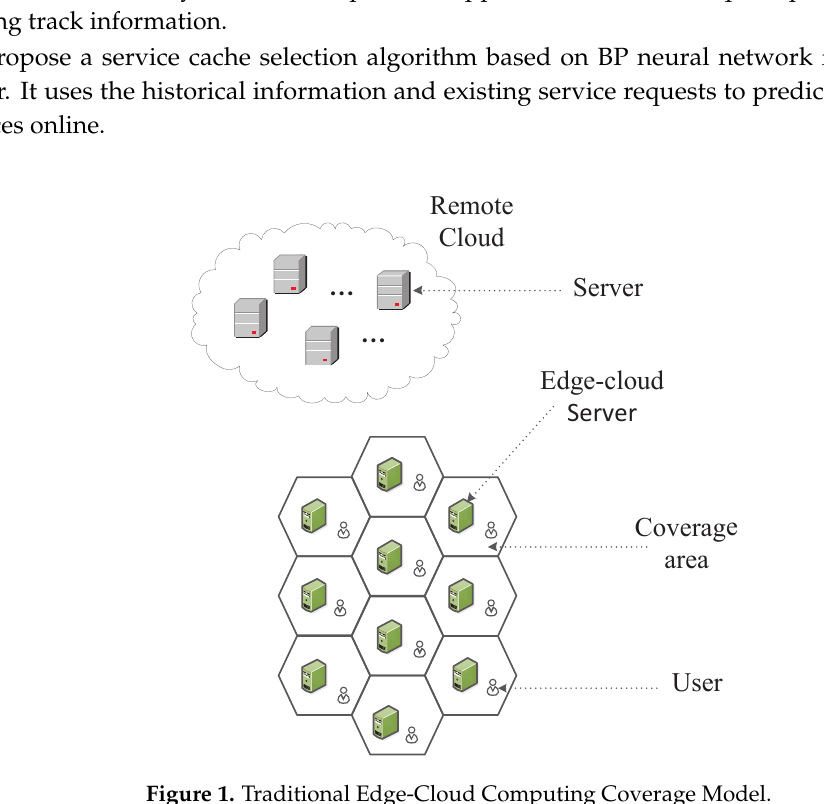
Figure 1. Traditional Edge-Cloud Computing Coverage Model.